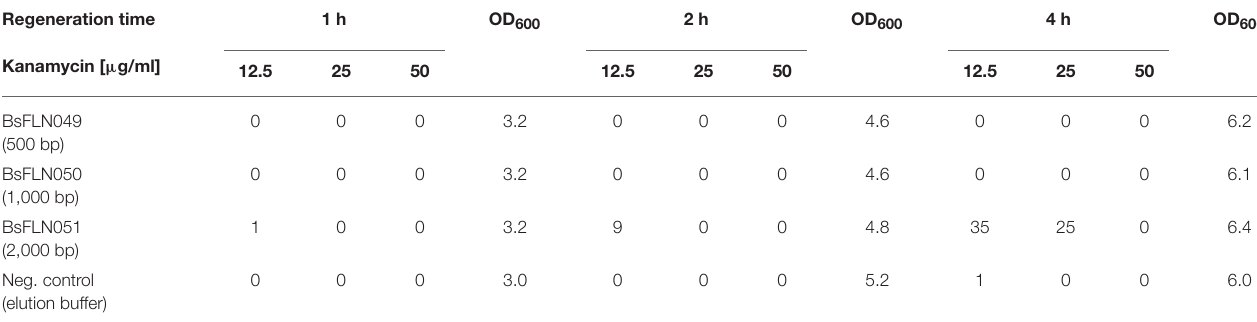
TABLE 1 | Optimization of transformation conditions. Numbers given correspond to colony forming units. Regeneration time